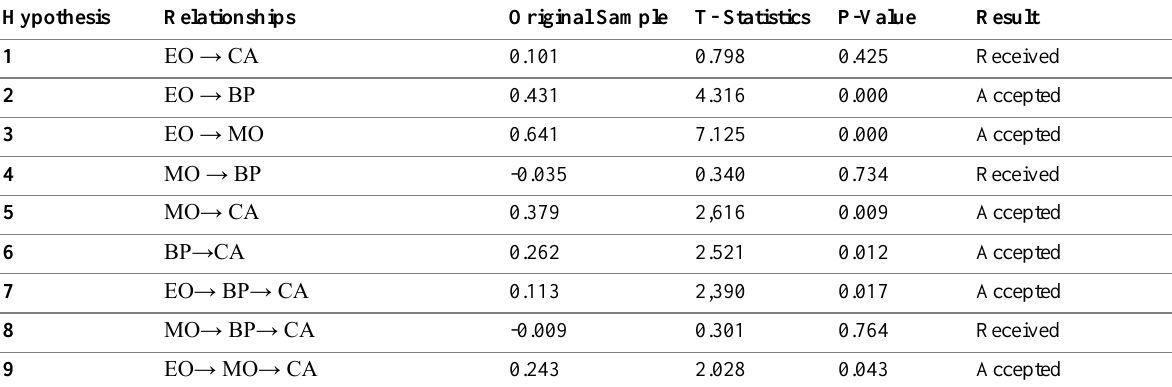
Table 3: Variables, Indicators, Loading Factors, AVEs, and Composite